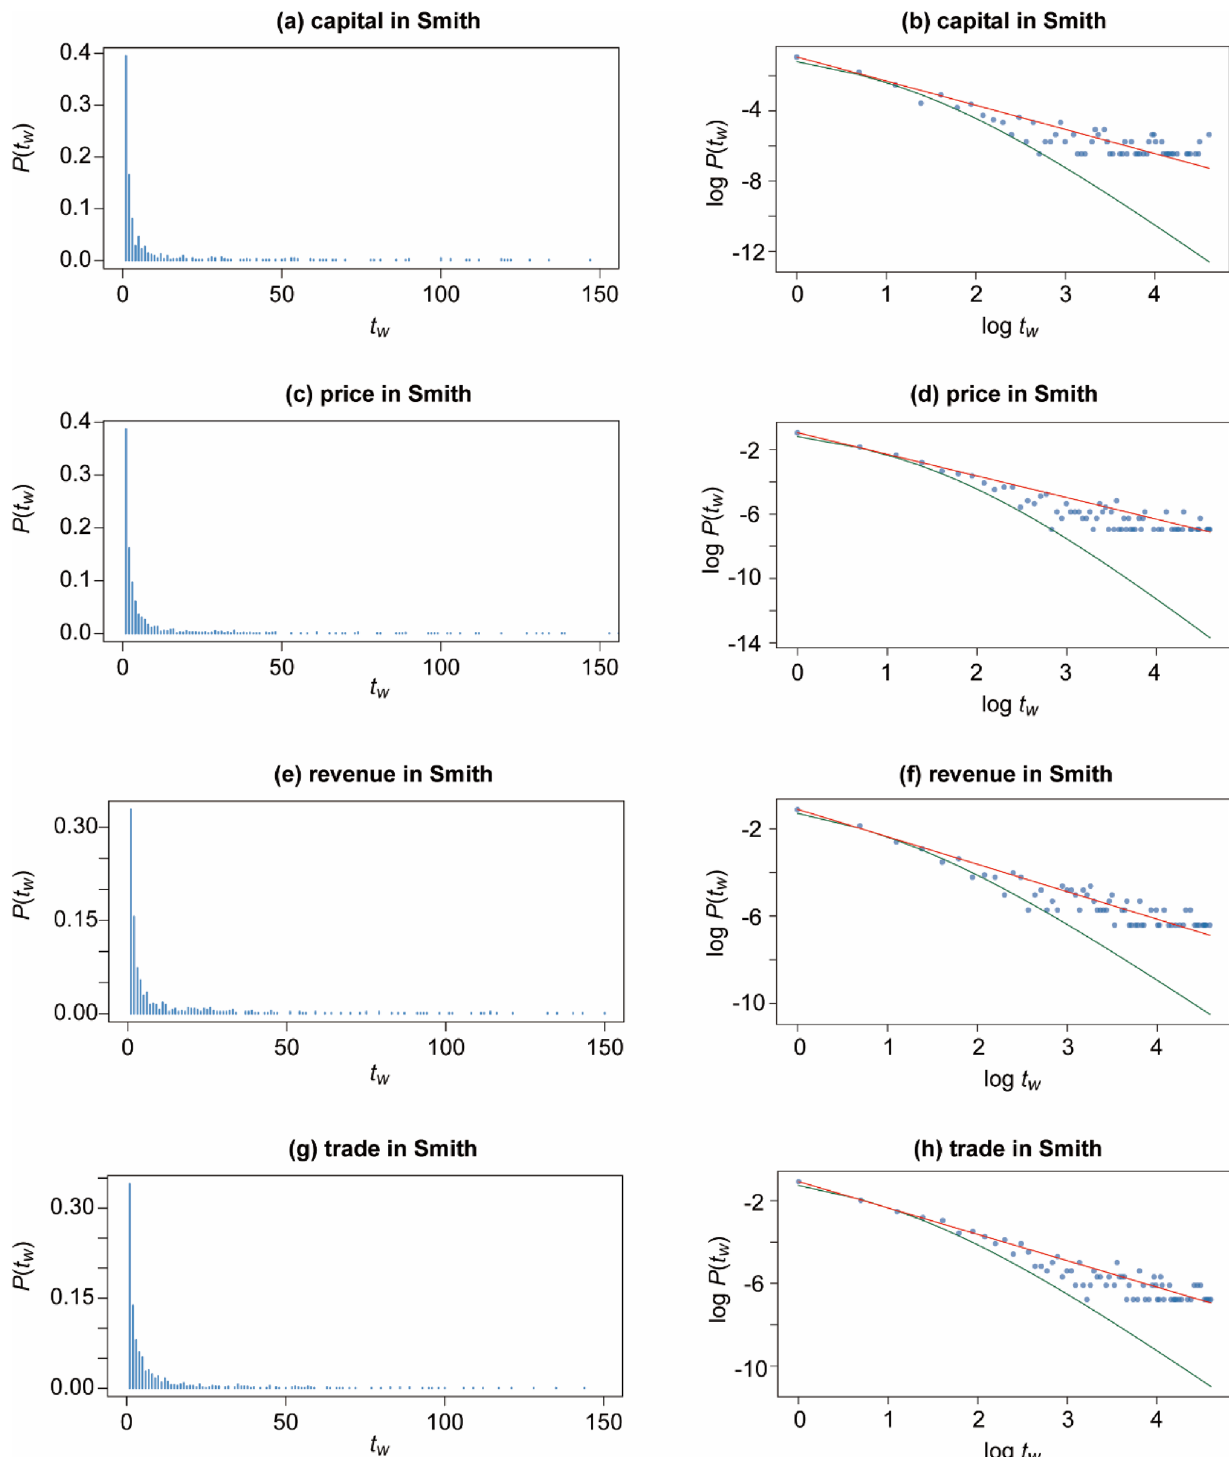
straight lines correspond to the best fitted hierarchical distribution, which will be described in subsection 3.4. Results are for the words “capital” (( a ) and ( b )), “price” (( c ) and ( d )), “revenue” (( e ) and ( f )), and “trade” (( g ) and ( h )), which are typical Type-I words picked from the Smith